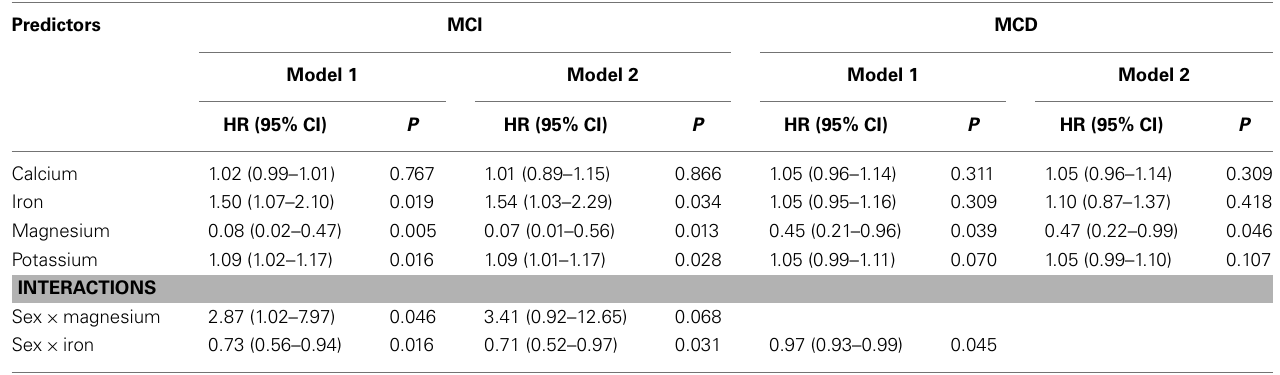
Table 2 | Dietary predictors of transition from normal aging to MCI or MCD